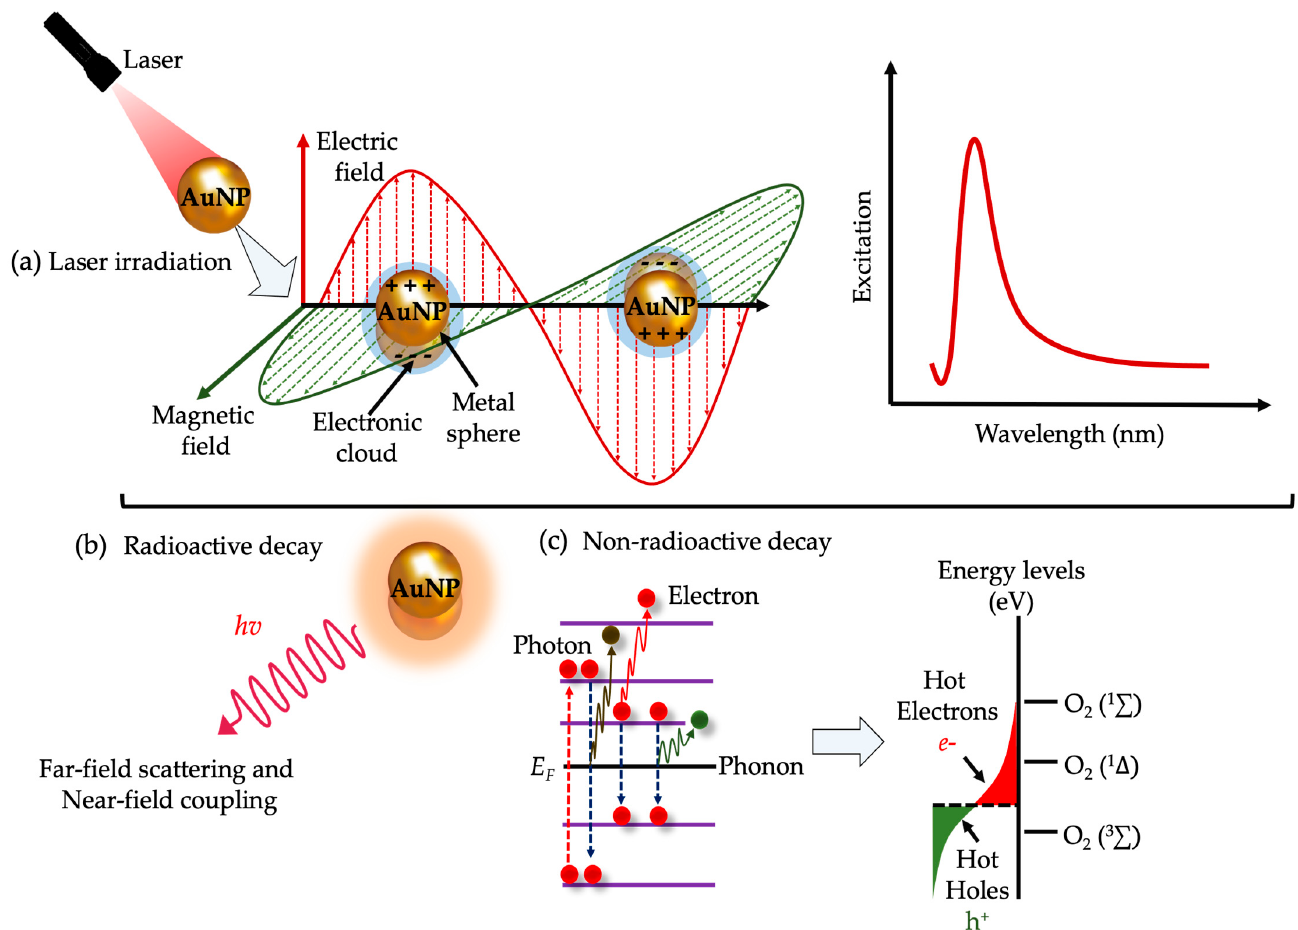
Figure 2. Schematic representation of surface plasmon resonance (SPR) of metallic nanoparticles (NPs). Photoexcitation and relaxation of plasmonic NPs generate localized surface plasmon resonance (LSPR) ( a – c ). Post-irradiation, plasmonic NPs may undergo two major processes, i.e., radioactive decay /or non-radioactive decay ( b , c ). Radioactive decay can either lead to far-field light scattering into adjacent nanostructures, or/electromagnetic fields, i.e., near-field ( a , b ). Alternatively, LSPR can undergo a non-radioactive decay process in which intraband or/interband excitation levels within the conduction band of a metallic NP can result in the generation of hot electrons ( c ). The interactions of high energy hot electrons with molecular oxygen (O 2 ) can result in the generation of cytotoxic reactive oxygen species (ROS). Further, the electronic energy states of hot electrons and holes are depicted by the colors red and green respectively ( c ).